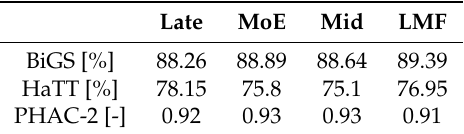
Table 5. Outcomes of multi-modal fusion methods obtained for models trained on datasets containing noised/zeroed inputs from the leading modality, but tested on the dataset without such samples. Late MoE Mid LMF